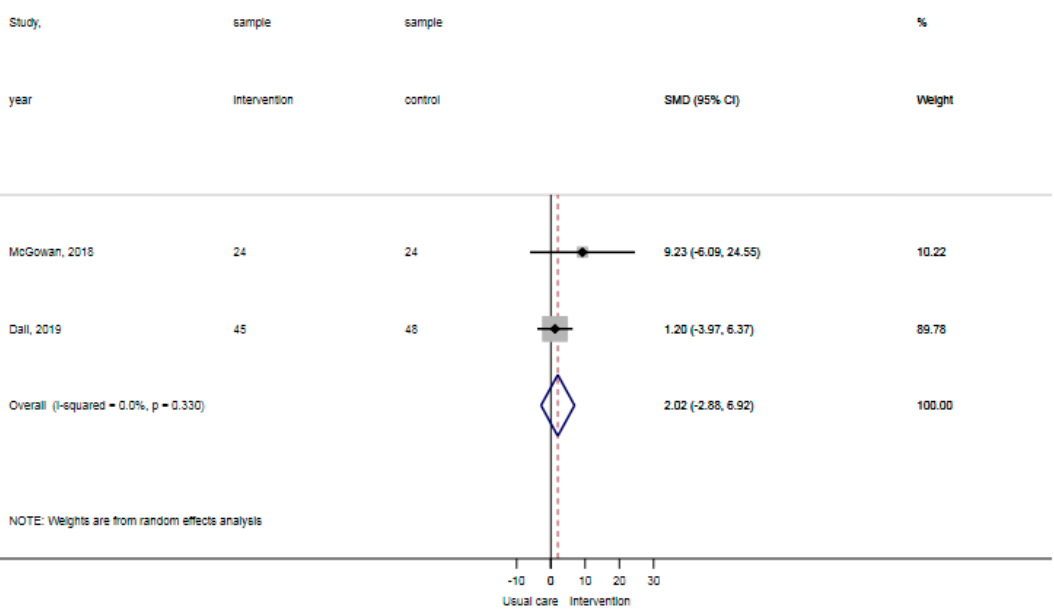
Figure 3. Figure 3. Forst plot time spent standing and walking showing no statistically significant difference between usual care and intervention.